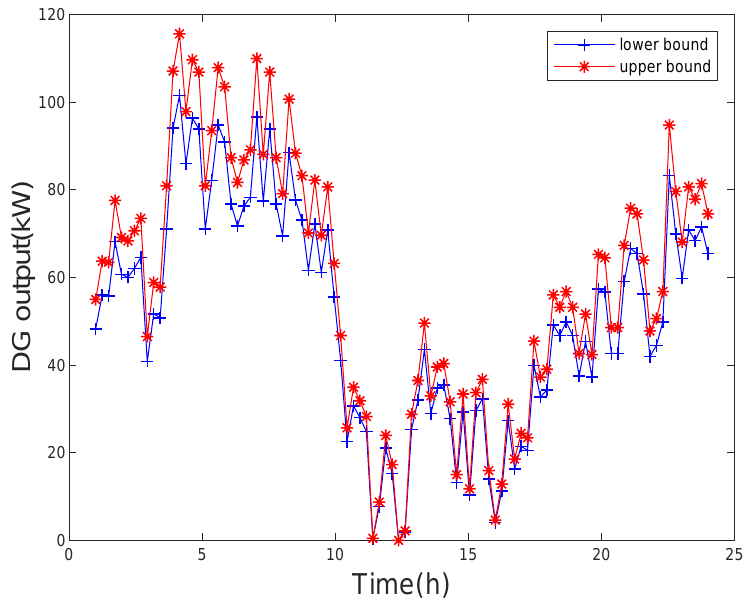
Figure 2. DG outputs of one